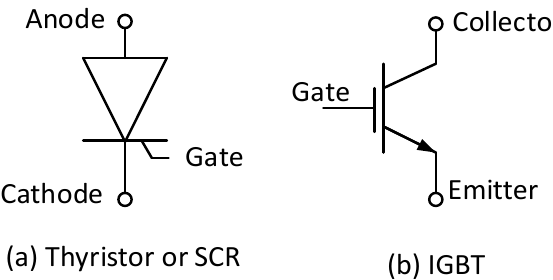
Figure 3. Basic Solid-state switches ( a ) Thyristor or Silicon Controlled Rectifier ( b ) Insulated Gate Bipolar Transistor.